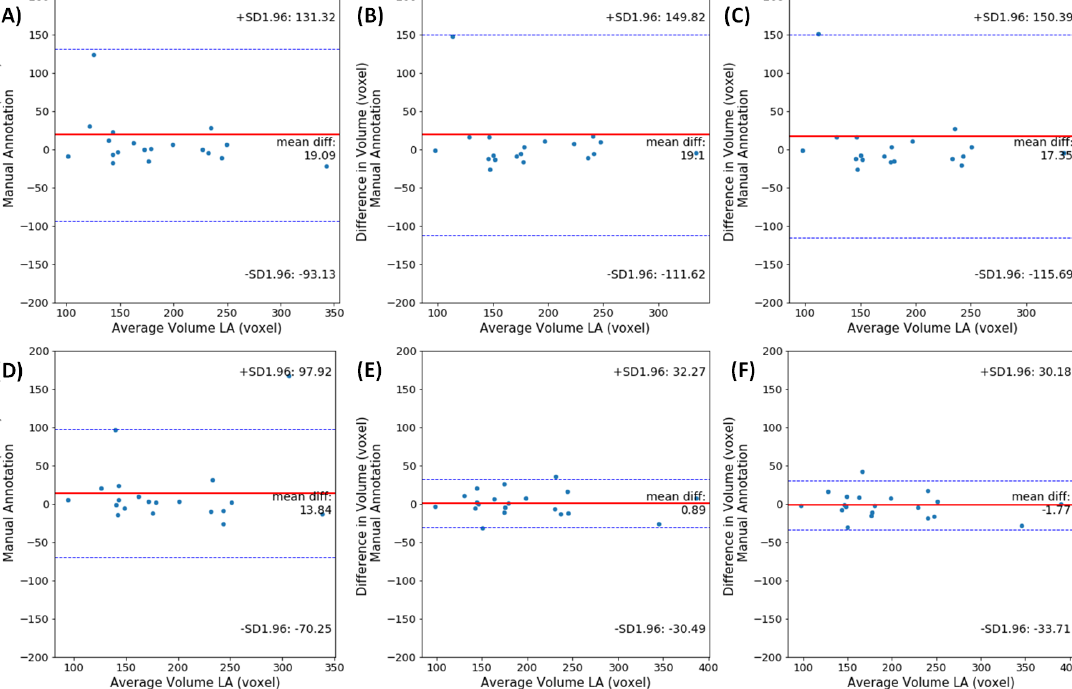
Figure 7. Bland–Altman graphics presenting the differences between volumes obtained by manual and automated segmentation methods, plotted against the mean of the 2 measurements for LASC dataset. Volumes per patient are expressed in mm 3 . The solid lines(red) indicate the mean bias and the dashed lines(blue) show the 95% CI ( ± 1.96 SD). Each plot displays the agreement between method segmentation output against the ground truth, ( A ) 3D UNet, ( B ) 3D VNET, ( C ) 3D DR-UNet, ( D ) 3D DR-UNet End-2-End, ( E ) 3D DR-UNet multi-stage with eight filters and ( F ) 3D DR-UNet multi-stage with 16